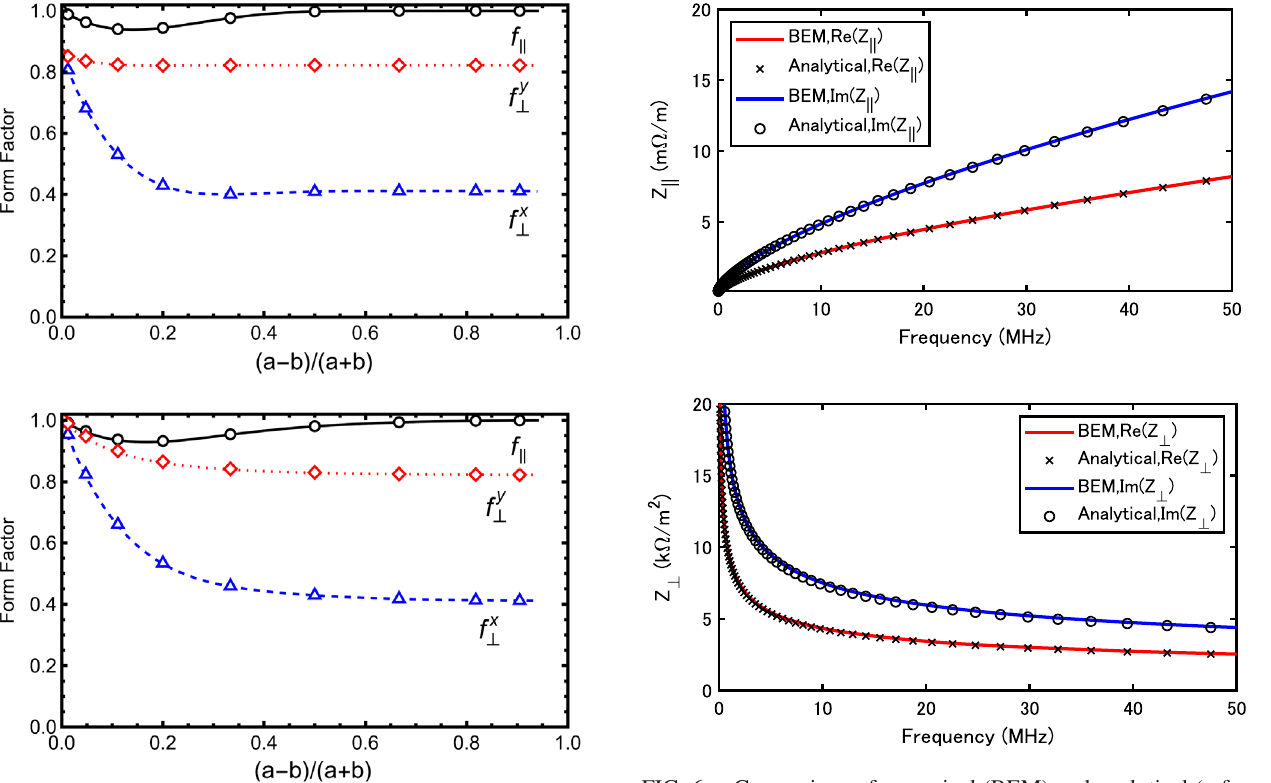
FIG. 6. Comparison of numerical (BEM) and analytical (refer- ence) EASE resistive-wall impedances for a uniform cylindrical FIG. 5. Comparison of numerical (BEM) and analytical (refer- beam with radius r b ¼ 0 . 1 mm and γ ¼ 10 000 and an aluminum ence) form factors f (black), f x ⊥ (blue), and f y ⊥ (red) calculated k round vacuum chamber with radius b ¼ 2 . 5 mm. Top: longi- for rectangular and elliptical chambers with fixed vertical tudinal. Bottom: dimension 2 b ¼ 5 mm. Top: rectangular chamber. Bottom: elliptical chamber. Analytical results: solid, dotted, and dashed lines. Numerical results: circle, diamond, and triangle.